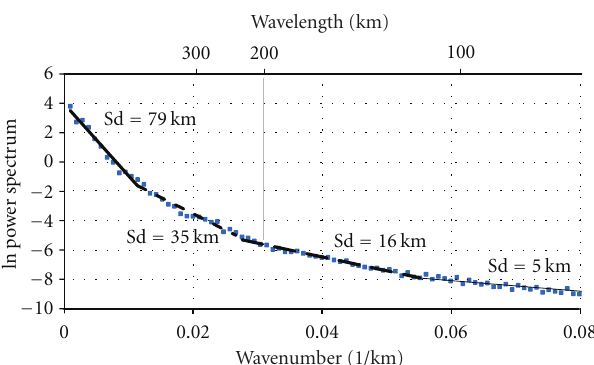
Figure 4: Graph representing the natural logarithm of the radially averaged power density spectrum versus the radial wavenumber and wavelength for the Bouguer anomaly map (blue points). The straight lines present the power spectra of mass points located at a maximum estimated depth. Four sources were recognized with estimated depths (Sd) of 79, 35, 16, and